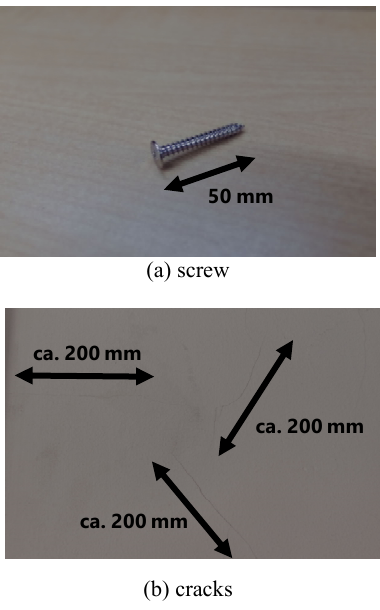
Figure 18. Targets of applications